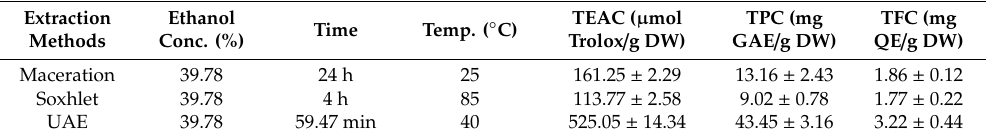
Table 4. The comparison of UAE with the maceration and Soxhlet extraction.